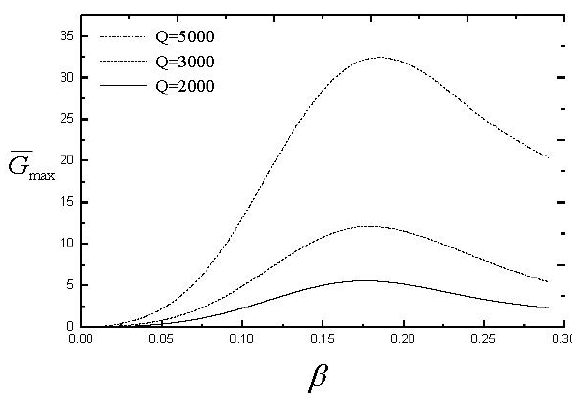
Figure 8. Effect of delamination length on maximum of energy re- lease rate